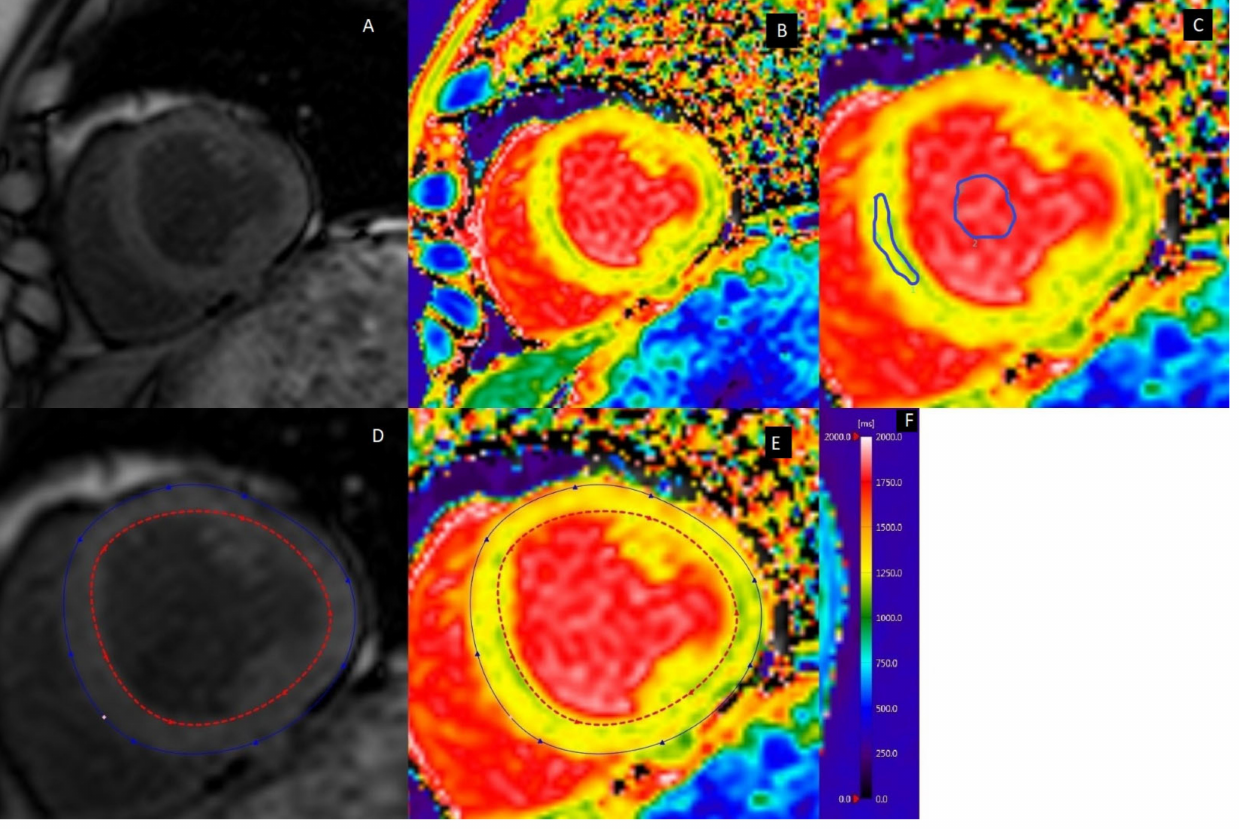
Figure 2. A typical example of a native T 1 map. ( A ) Anatomical reference image of a left ventricle short-axis view. ( B ) Superimposed heat map showing the different T 1 relaxation times for different tissues. ( C ) Regions of interest drawn in the mid-septal region and ventricular cavity. ( D ) Global myocardial T 1 relaxation times can be determined by denotation of the entire left ventricular wall. ( E ) Superimposition of the drawn contours from image D on the T 1 map. ( F ) Heat map scale with T 1 relaxation times ranging from 0 to 2000 ms